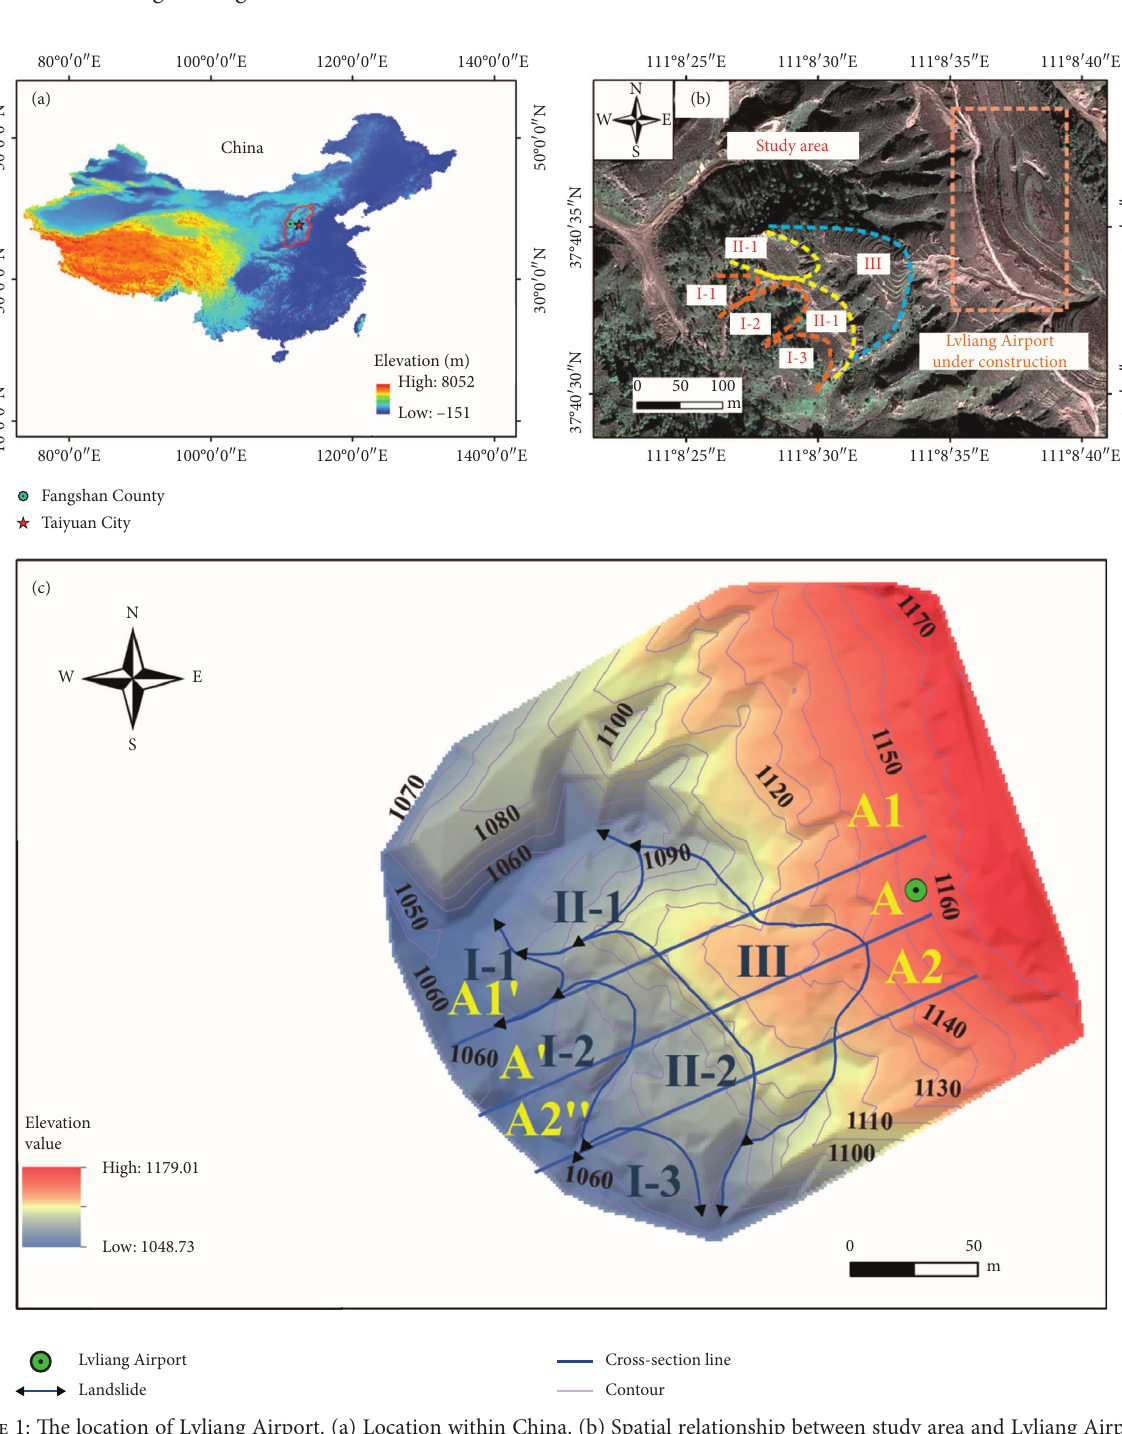
Figure 1: The location of Lvliang Airport. (a) Location within China. (b) Spatial relationship between study area and Lvliang Airport. (c) Plan view and location of the